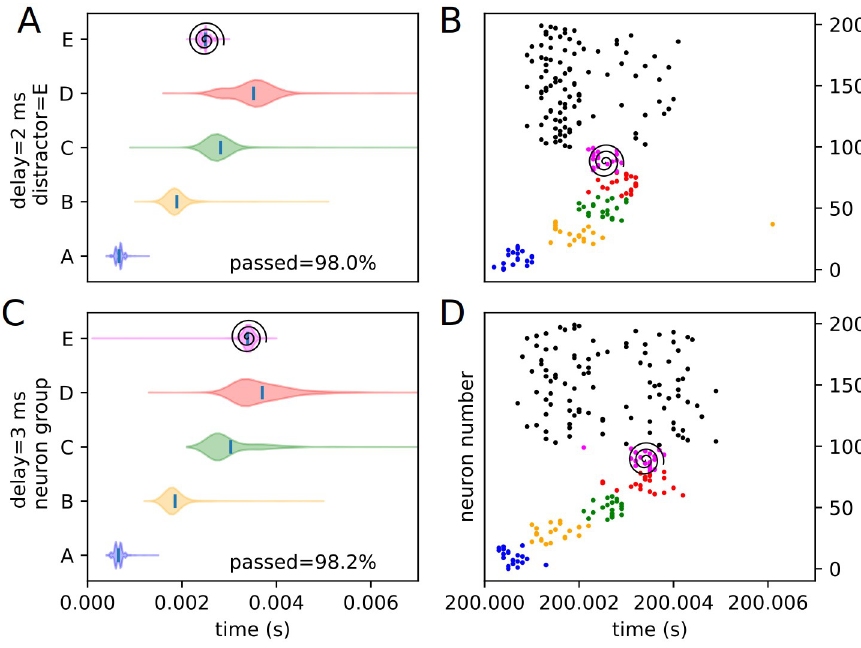
Fig 17. Experimental peak densities for late distractors at position E. Violin plots (densities estimated with a 50 point Gaussian kernel) of the peak times for the second two temporal variants of distraction at position E, with listed percentages of trials passing veto. A raster plot of an example distracted recall is also included. The spiral indicates the location of the distractor. (A) Violin plot for distractor E with 2 ms delay. (B) Example replay for distractor E with 2 ms delay. (C) Violin plot for distractor E with 3 ms delay. (D) Example replay for distractor E with 3 ms delay.